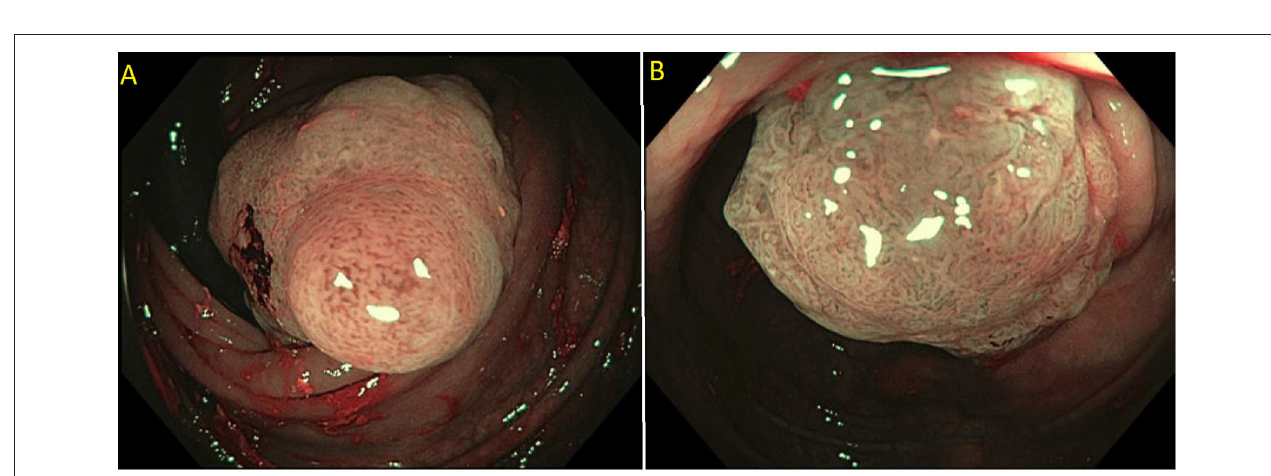
FIGURE 3 | (A) NICE type I (hyperplastic polyp); (B) Paris I-s, NICE type II (tubular adenoma without high grade dysplasia); (C) Paris IIa + is lateral spreading lesion, NICE type II (tubulovillous adenoma without high grade dysplasia); (D) NICE type III (adenocarcinoma) as see on white light. Note the invisible surface pattern with avascular area, highlighted in yellow; (E) NICE type III (Adenocarcinoma) as see under NBI.